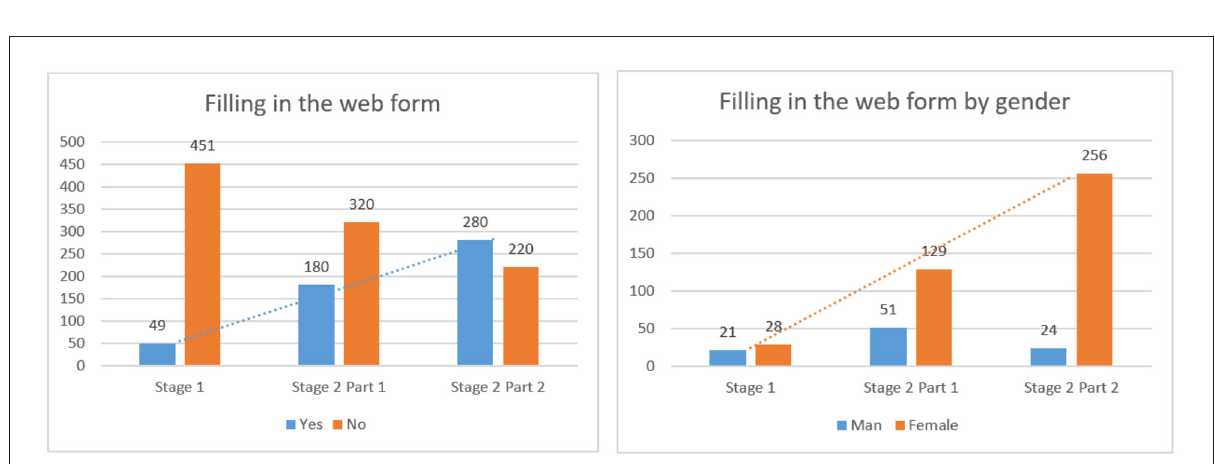
FIGURE7 Results of the experiment. Source: Researchers’ elaboration based on research data.